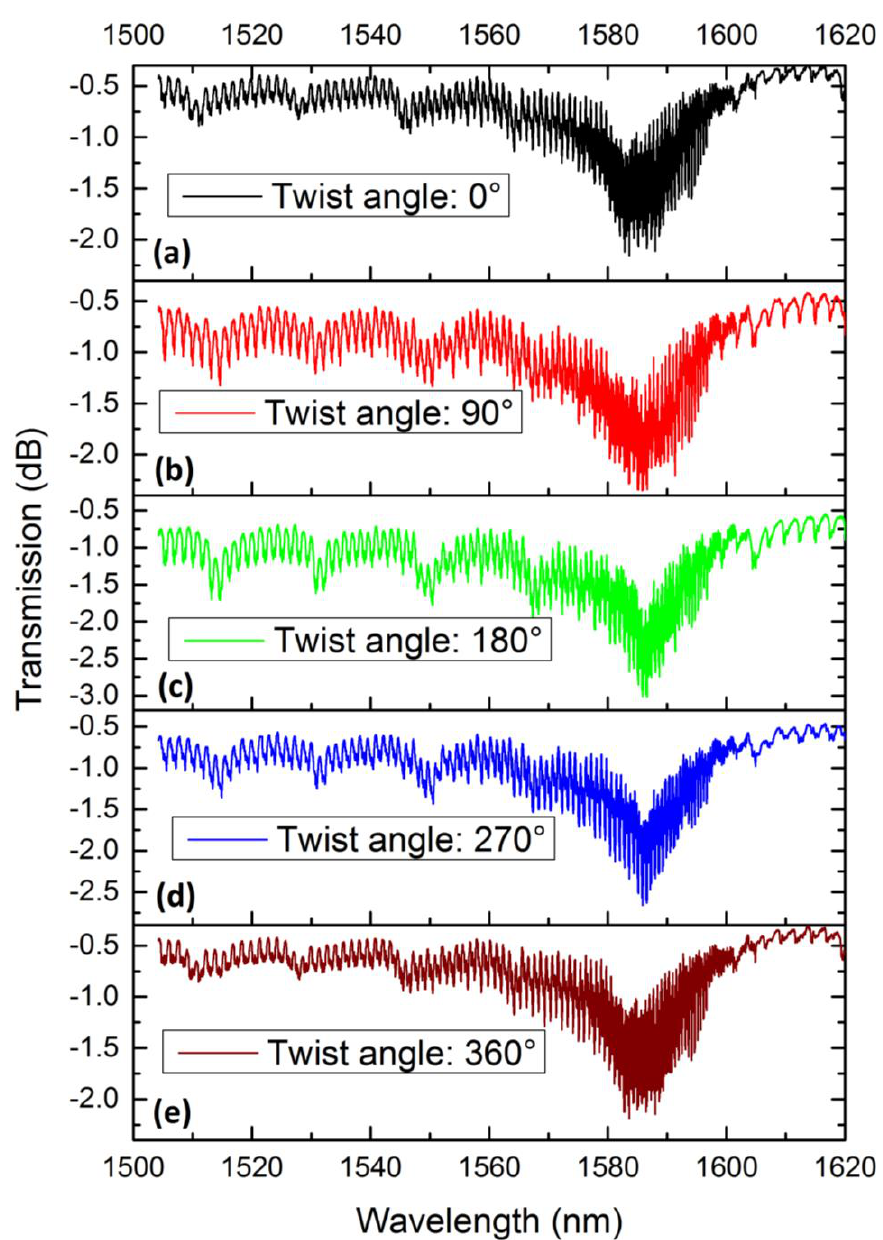
Figure 11. Spectra of the 8th order 6°TFBG under different twist angles: ( a ) 0°, ( b ) 90°, ( c ) 180°, ( d ) 270° and ( e ) 360°.